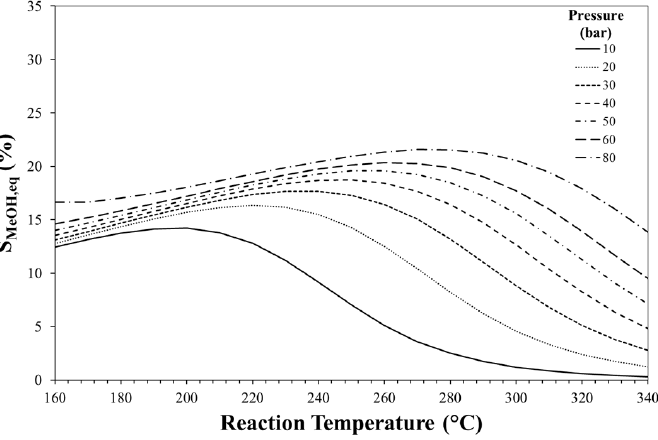
Figure 5. Effect of reaction temperature and pressure on methanol equilibrium selectivity. Initial H 2 /CO 2 molar ratio equal to 3.